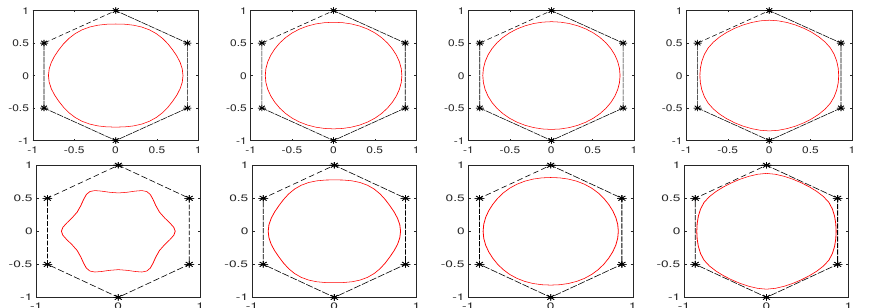
Figure 2. Curves generated by the scheme { S a k } k ≥ 0 with v 0 = − 0.75, − 0.3, cos ( π /3 ) , 3 (from left to right) and β = 0 (top row), 1.5 (bottom